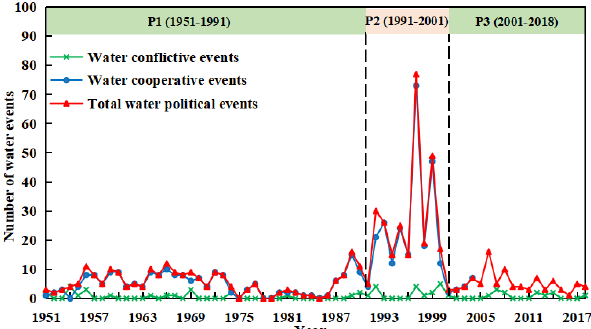
Figure 7. Changing trends in water conflictive, cooperative, and to- tal water political events in Central Asia from 1951 to 2018. Note: P1 – a stable period; P2 – a rapid increase and decline period; P3 – a second stable